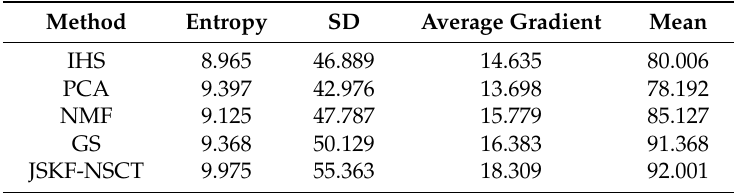
Table 7. Comparison of evaluation for five fusion methods for experiment